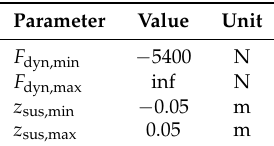
Table 2. Output constraints.